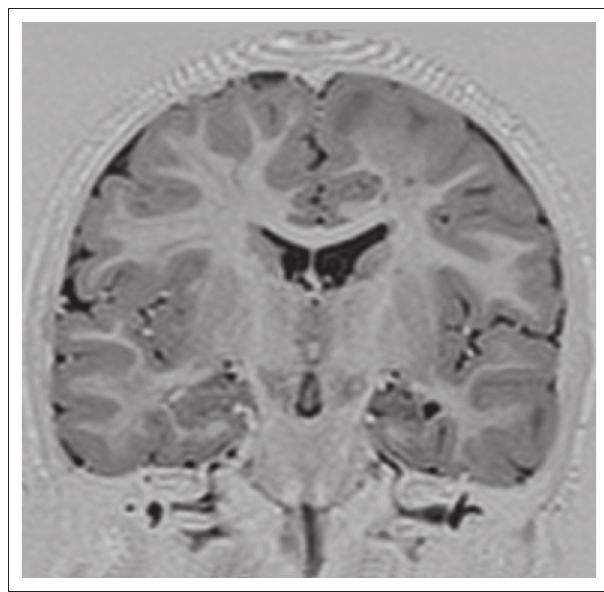
FIGURE 5: Coronal T1-weighted MR image. FIGURE 6: Coronal T1 Inversion Recovery MR